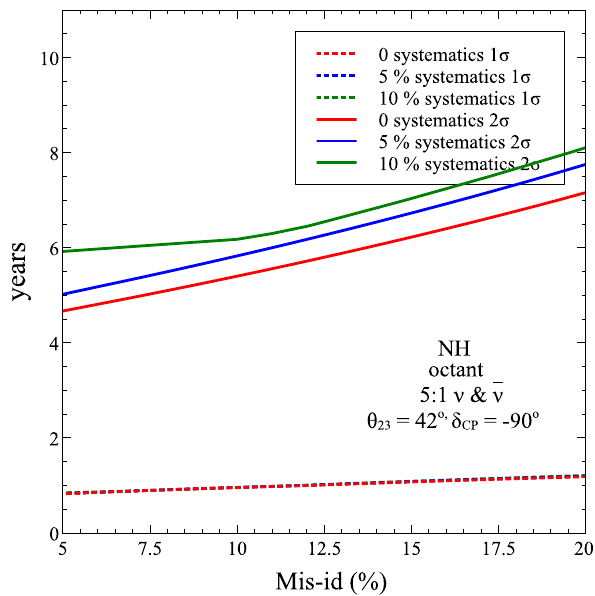
Fig. 6 Effect of background and systematics in octant sensitivity for NH in terms of runtime required to achieve a sensitivity of a certain confidence level. This is shown for θ 23 (true) = 42 ◦ and δ CP (true) = − 90 ◦ as for this set of parameters are close to the present best-fit